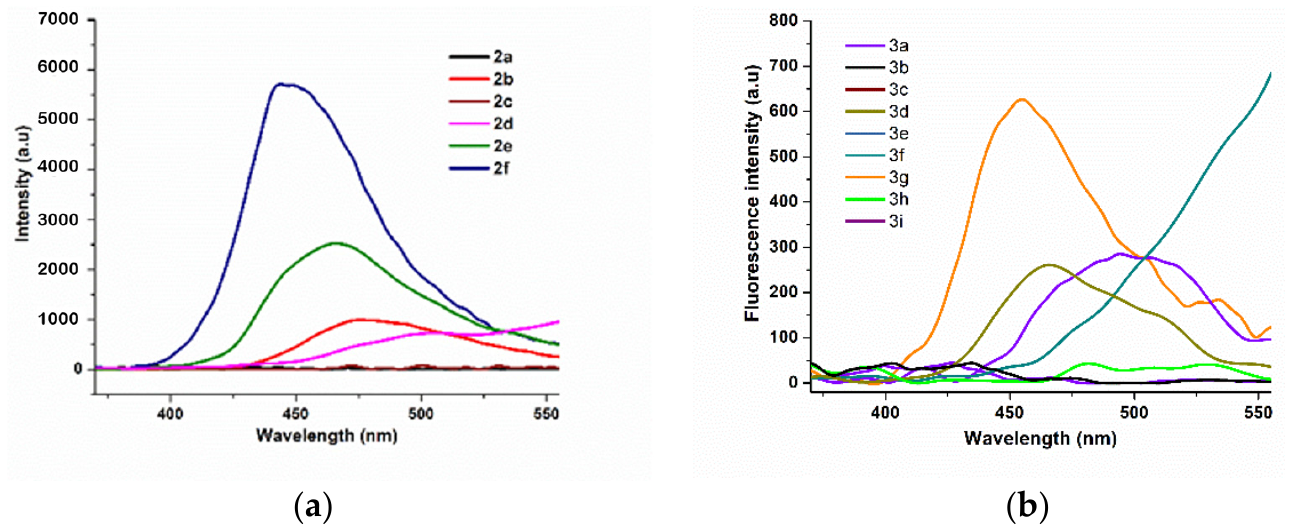
Figure 2. Emission spectra of the monoarylated DPDTEs ( 2a – f ) ( a ) and diarylated DPDTEs ( 3a – i ) ( b ) in CHCl 3 at 298 K (C = 10 − 5 M) with λ ex = 360 nm. Table 2. Photophysical data of the arylated DPDTE ( 2a – f , 3a–i ).